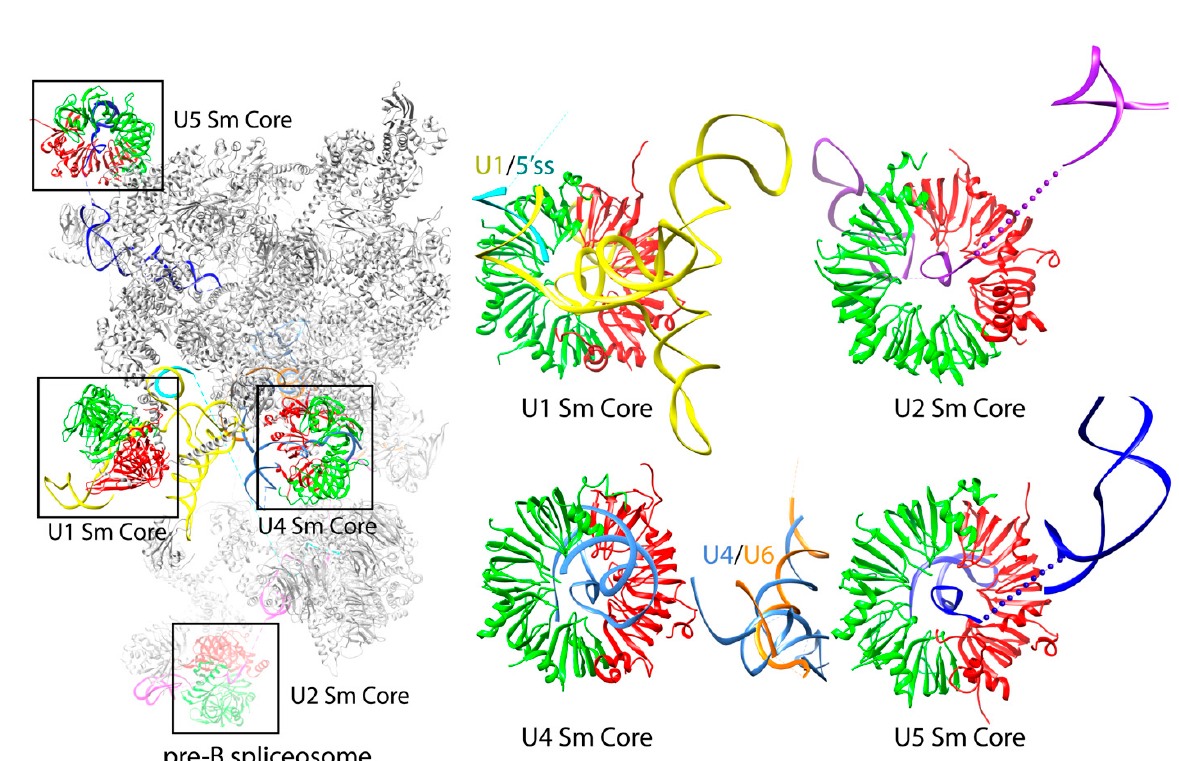
Figure 4. The 3.3 Å Cryo-EM structure of Pre-B spliceosome captured before U1 snRNP dissociates (PDB:6QX9). The model is depicted in ribbons representation. The D2/D1/B sector of the four core domains is colored in red and D3/G/E/F is colored in bright green; all other protein components are colored in grey. U1 snRNA (yellow), U2 snRNA (purple), U4 snRNA (light blue), U5 snRNA (dark blue), U6 (orange), and pre-mRNA (cyan). The functionally important RNA structures all bend toward the D2/D1/B sector. Thus, the direction of the RNA backbone 5 ′ to the Sm site is significant in positioning structural elements that eventually form the catalytic active site.